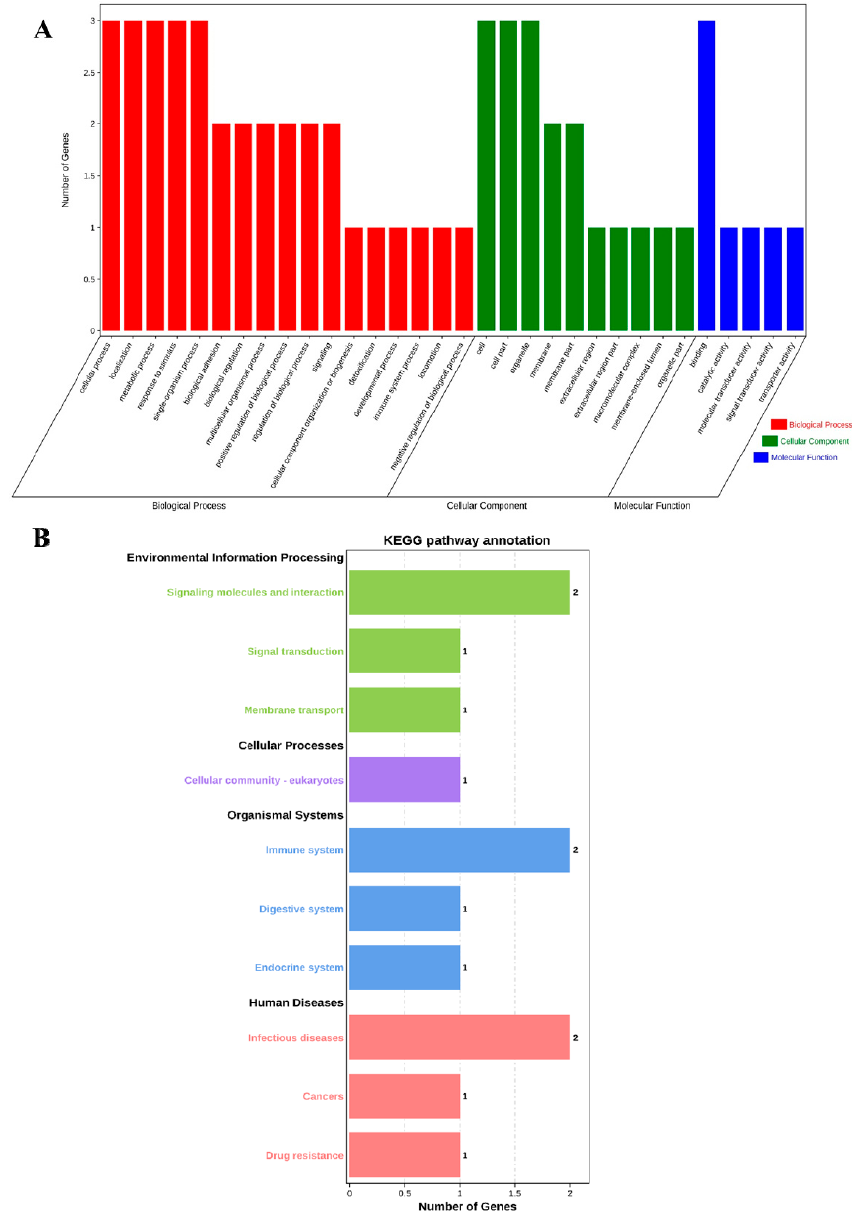
Figure 1. GO annotation and KEGG pathway enrichment of ABCG2 , CD44 and SPP1 genes. ( A ) GO annotation results of three genes in BP, CC and MF. ( B ) Distribution of enriched KEGG